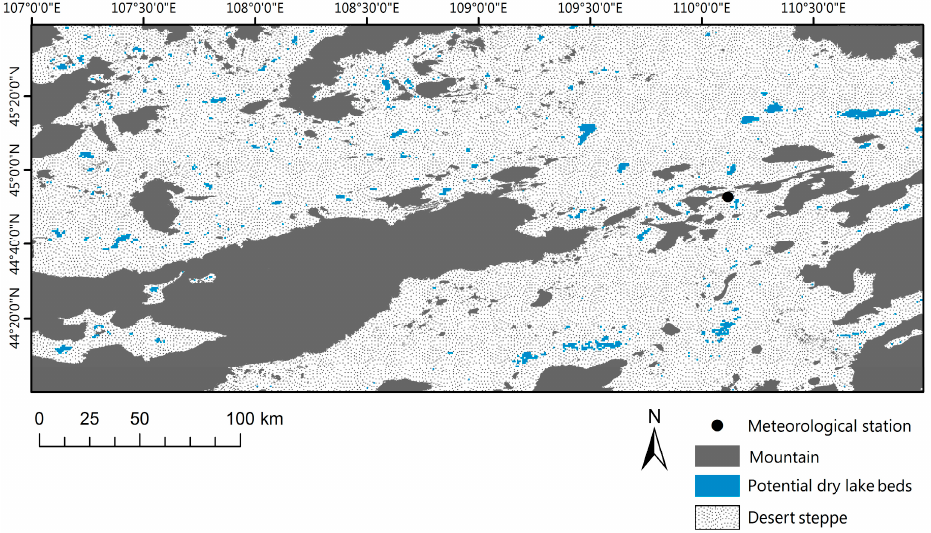
Figure 4. The distribution of three land cover types in the study area.